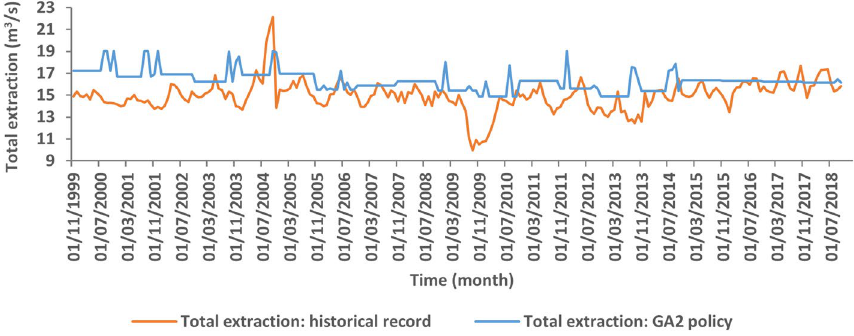
Fig. 13 The total extraction